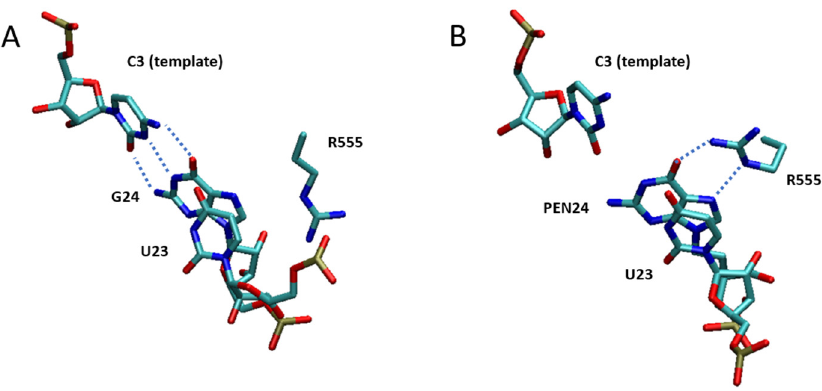
Figure 6. Images of the C3 (see Figure 1) in the template strand and side chain of R555 in ( A ): G24 and ( B ): PEN24. For clarity, hydrogen bonds are depicted by dots. Images were obtained by VMD software.